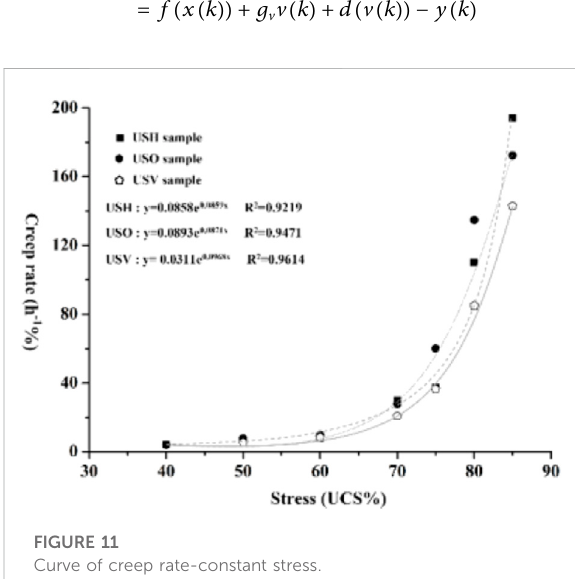
FIGURE 11 Curve of creep rate-constant